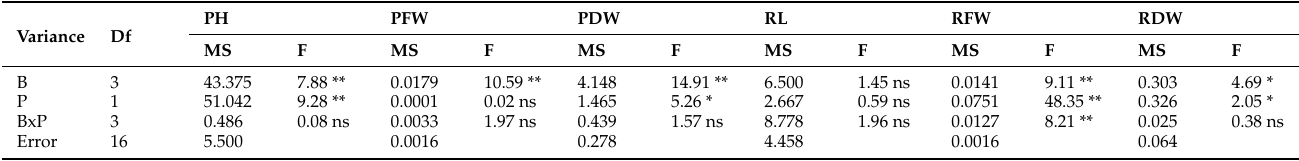
Table 3. Variance analysis table for the effects of biochar and PGPR applications on the development criteria of Siyez wheat.